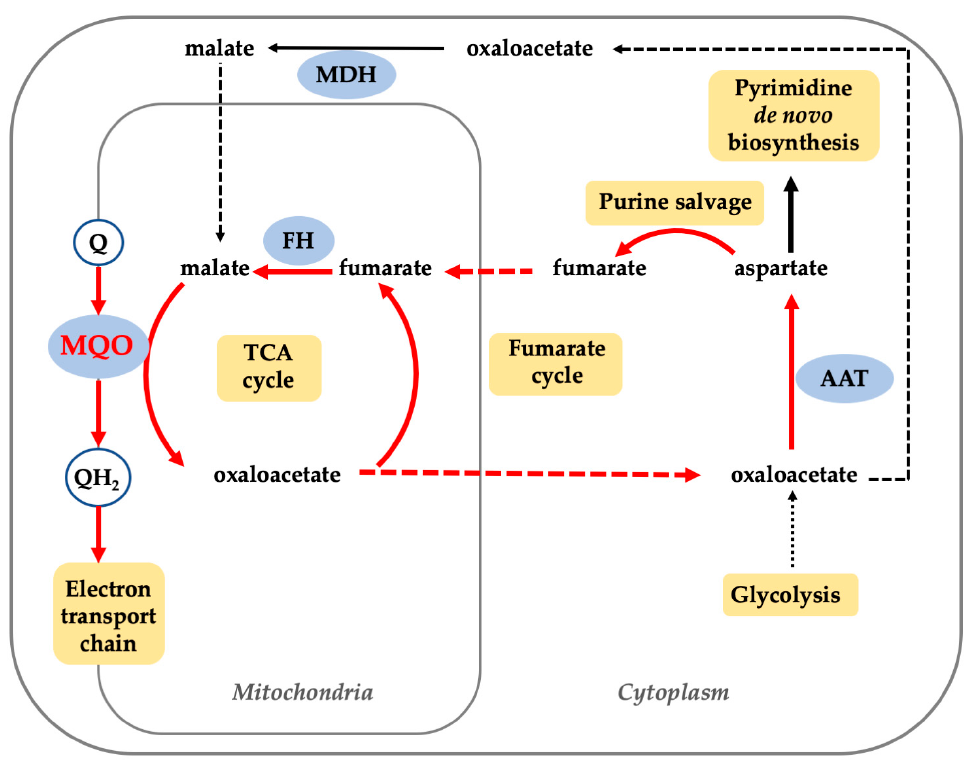
Figure 1. Scheme of the biological pathways in Plasmodium falciparum cells that PfMQO is involved with. Abbreviations, Q: ubiquinone; QH 2 : ubiquinol; FH: fumarate hydratase; AAT: aspartate aminotransferase; MDH: malate dehydrogenase.